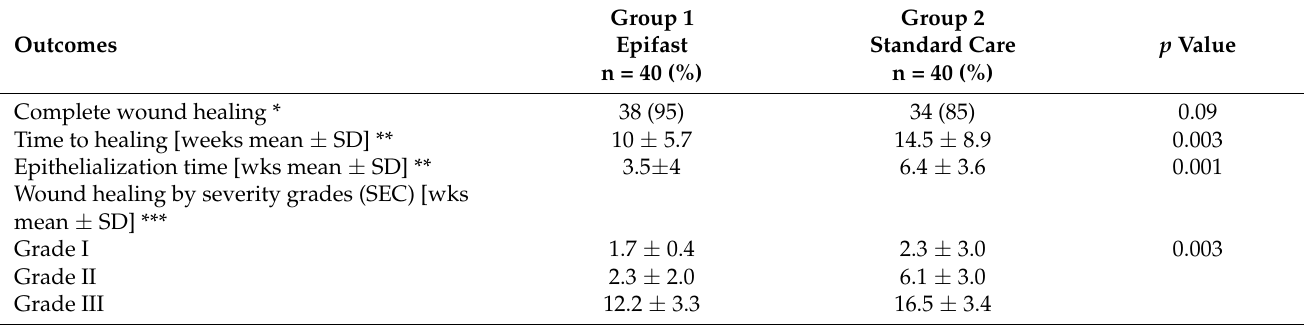
Table 2. Average duration of epithelialization, wound healing and severity grades for study